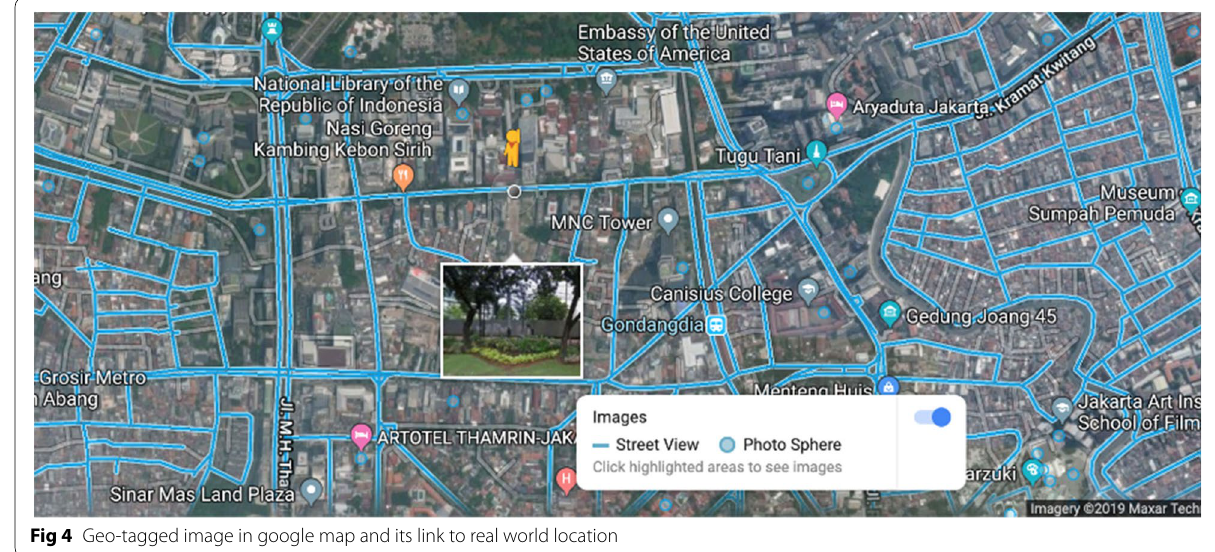
Fig 4 Geo-tagged image in google map and its link to real world